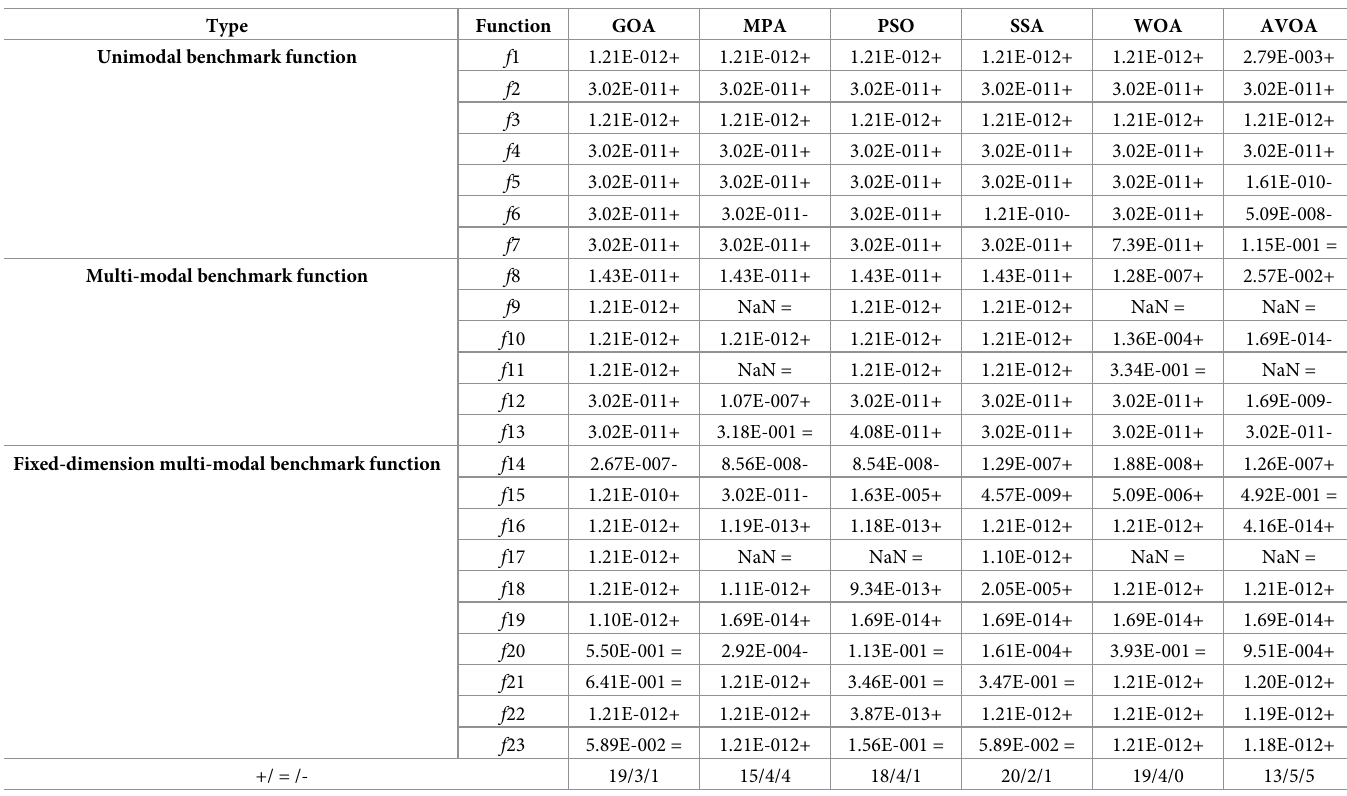
Table 6. The results of the Wilcoxon rank-sum statistical test with 5% among TAVOA and the 6 compared algorithms on the 23 basic benchmark functions. Type Function GOA MPA